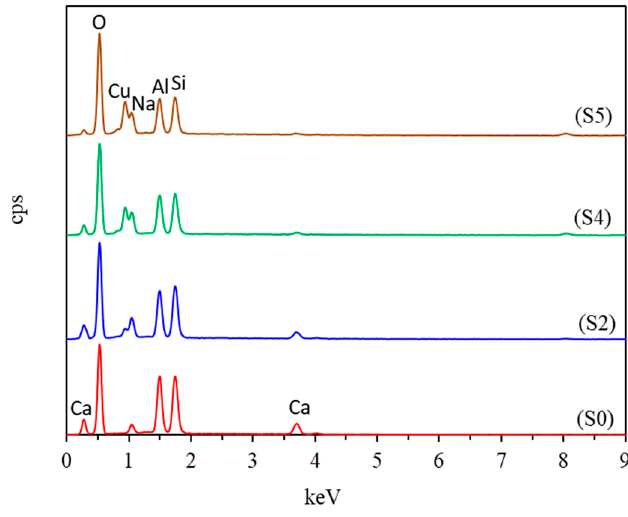
Figure 4. EDS of samples: (S0) zeolite 10X; (S2, S4 and S5) CuO-zeolite NCs.